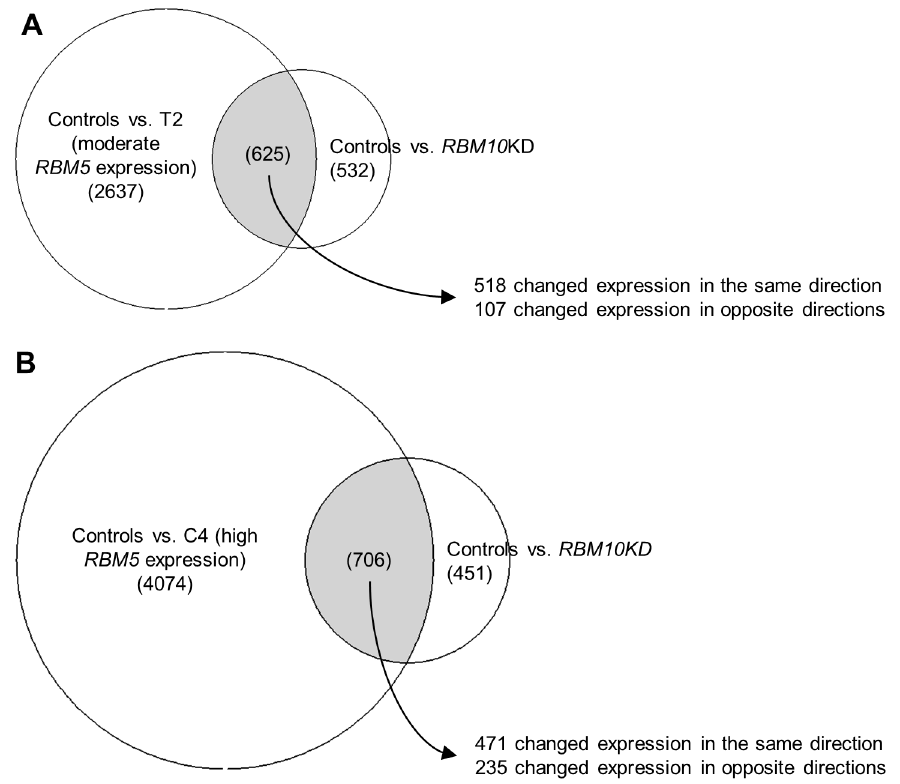
Fig 5. Comparison of genes differentially expressedupon RBM10KDin GLC20 cells or RBM5 expression in GLC20 sublines. Differentially expressedgenes, basedon RNA-Seqresults, in GLC20 cells upon RBM10KD, and moderate (A) or high (B) expressionlevels of RBM5 expression.